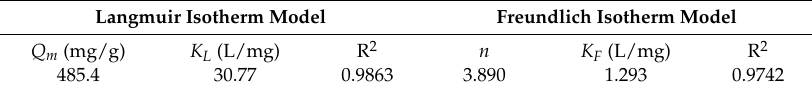
Table 2. The adsorption isotherm parameters for the loading of DOX by